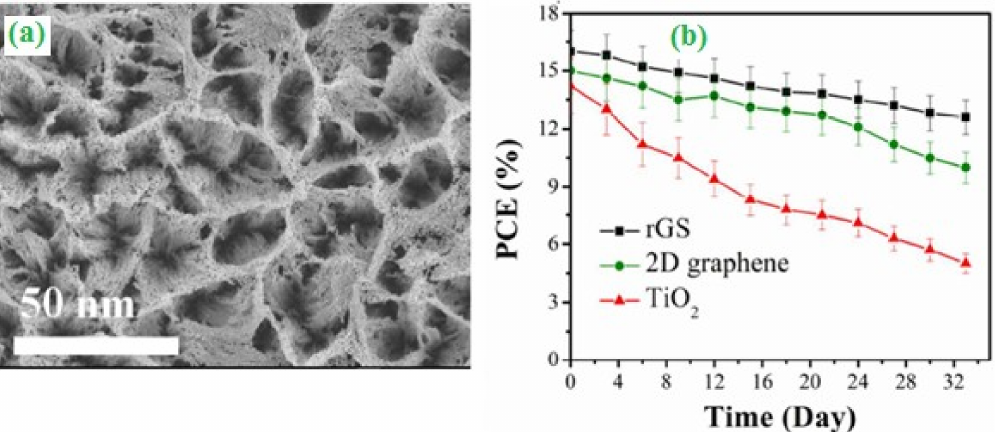
Figure 1. ( a ) SEM images of AgNWs films stored in ambient environment for one week directly on top of perovskite / hole transporting materials (HTM) active layer ( b ) J – V curves of perovskite solar cells (PSCs) with di ff erent intermediate Au layer thickness illuminated from the AgNWs side. Reprinted with permission from [54]. Copyright (2016), American Chemical Society.